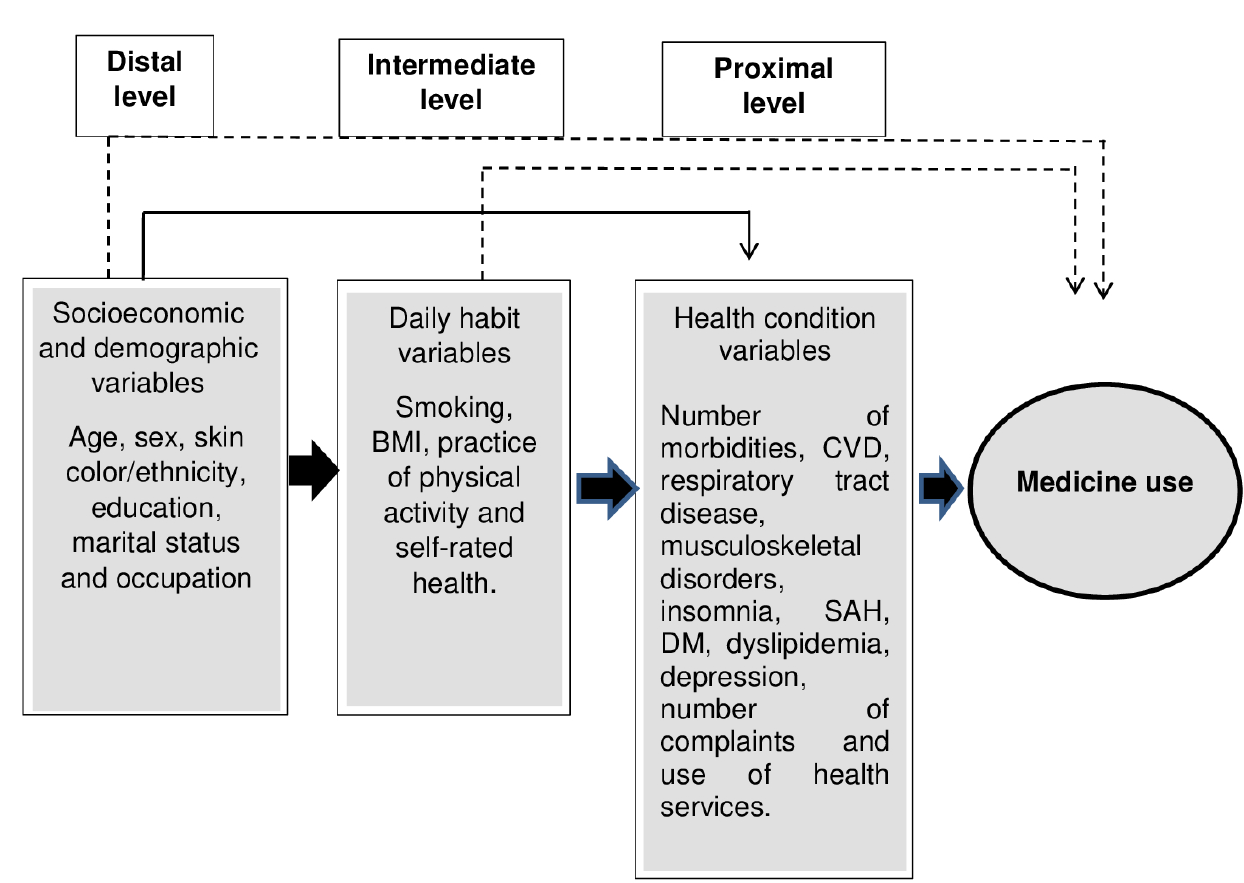
FIGURE 1 - Model of independent variables on Medicine use by hierarchical